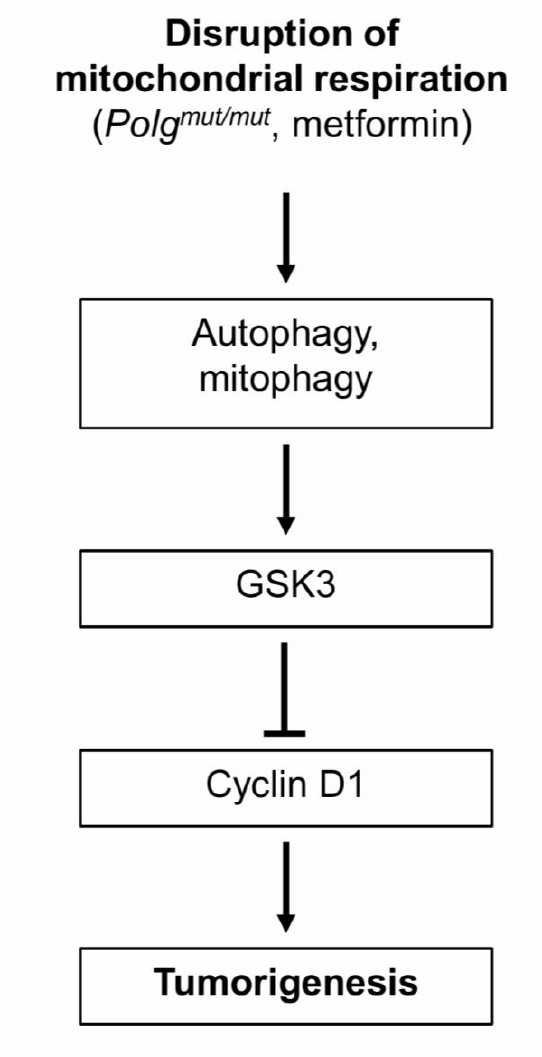
FIGURE 1: Proposed anti-proliferative signaling mechanism in response to mitochondrial inhibition. Inhibition of mitochondrial respiration genetically ( Polg mut/mut ) or pharmacologically (metfor- min) can delay tumorigenesis in association with induction of autophagy and GSK3-mediated suppression of cyclin D1 to affect cell cycle